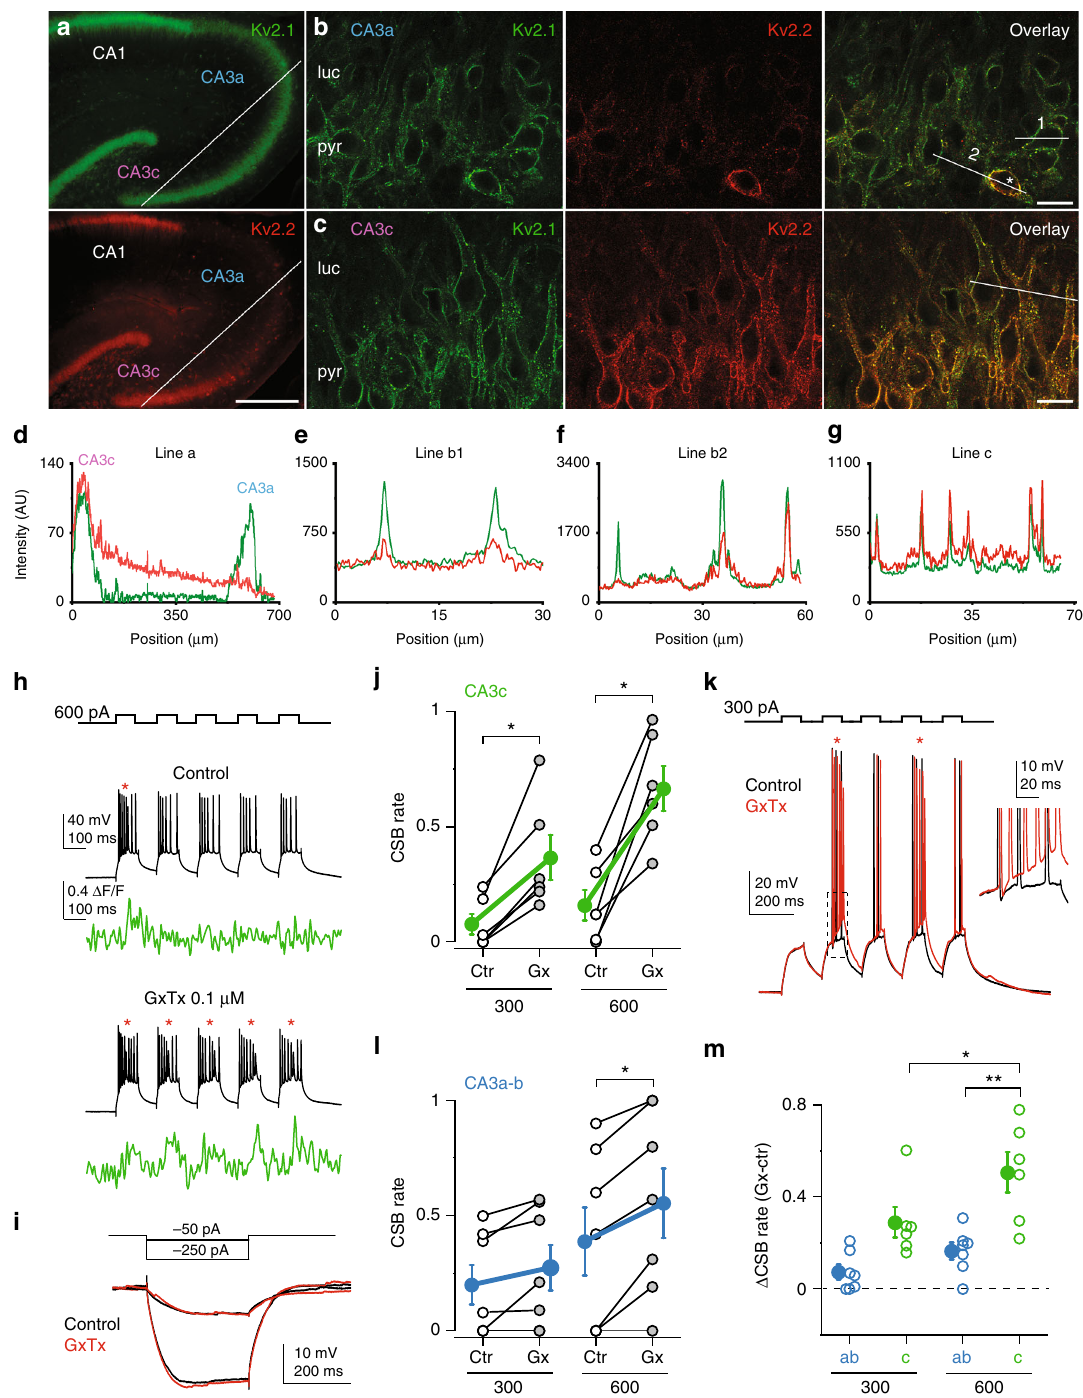
Fig. 7 Role of Kv2 channels in regulating CSB propensity. a Double immuno fl uorescent reaction showing the distribution of Kv2.1 (top) and Kv2.2 (bottom) subunits in the hippocampus. b , c High magni fi cation co-localization of the Kv2.1 and Kv2.2 subunits in the CA3a ( b ) and CA3c ( c ) areas. Asterisk in b marks an interneuron intensely labeled for the Kv2.2 subunit in CA3a. Scale bars: 200 μ m ( a ), 20 μ m ( b , c ). The stainings were replicated 19 times in 10 rats. d – g Intensity pro fi les of the Kv2.1 (green) and Kv2.2 (red) immunosignals measured along the indicated white lines in a – c . AU, arbitrary unit. h Representative experiment testing the effect of GxTx (0.1 μ M) on CSB rate in a CA3c PC. CSBs are indicated by red asterisks. Low-af fi nity Ca 2 + dye OGB-6 was used in this experiment. i Representative voltage responses to hyperpolarization in a CA3c PC in control and after GxTx